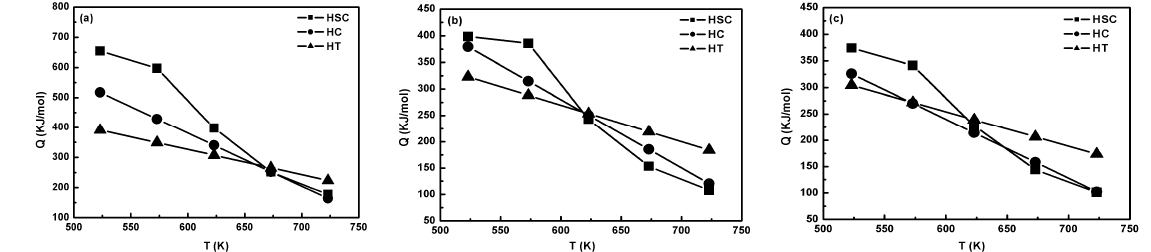
Figure 4. Relationship of hot deformation activation energy vs. deformation temperature for 7050 aluminum alloy under three deformation modes: ( a ) 0.01 s − 1 ; ( b ) 1 s − 1 ; ( c ) 10 s − 1 .